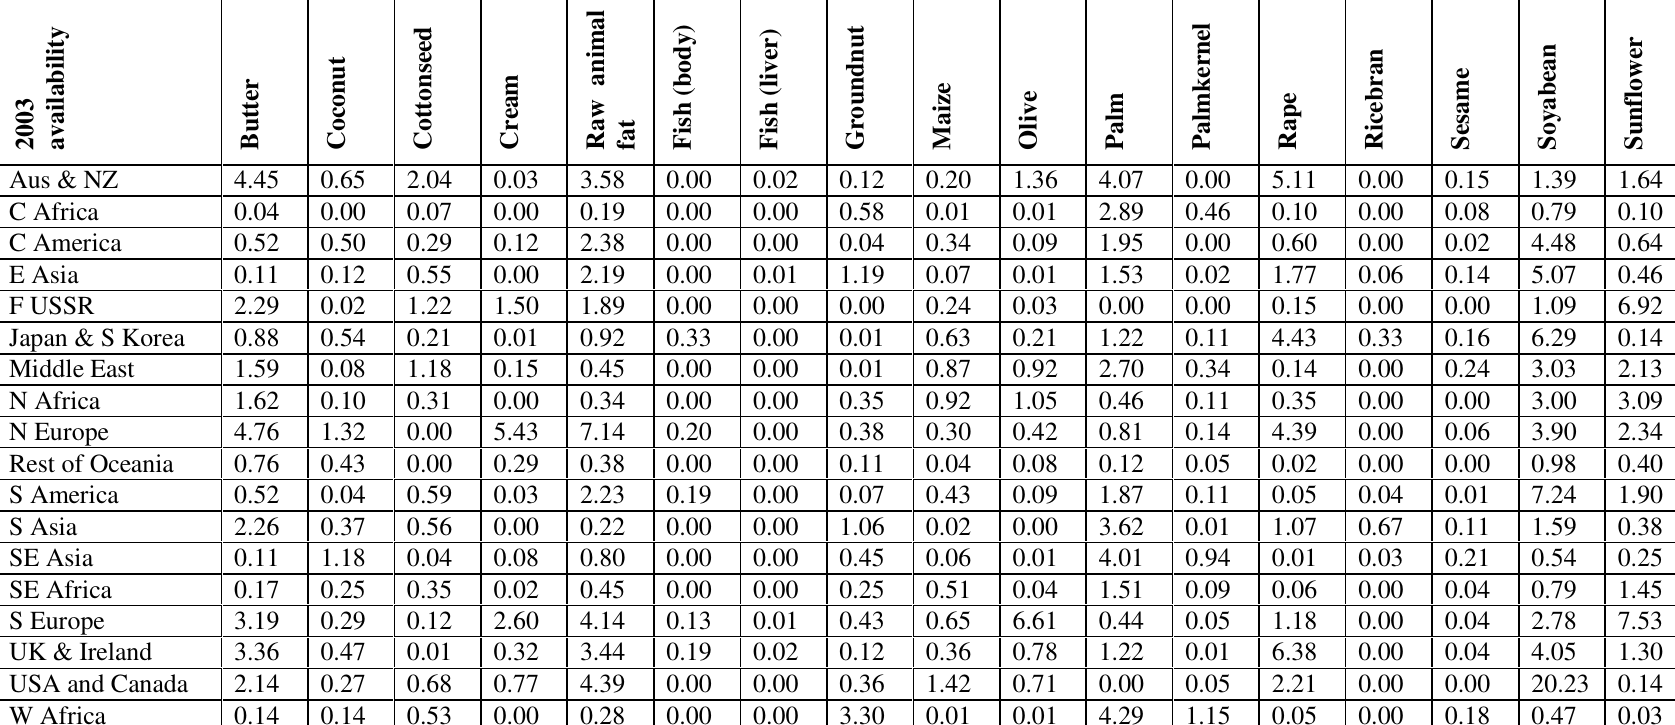
Table 2: World lipid availability, Kg/capita/year, 2003 (Source: FAOSTAT data, 2006).